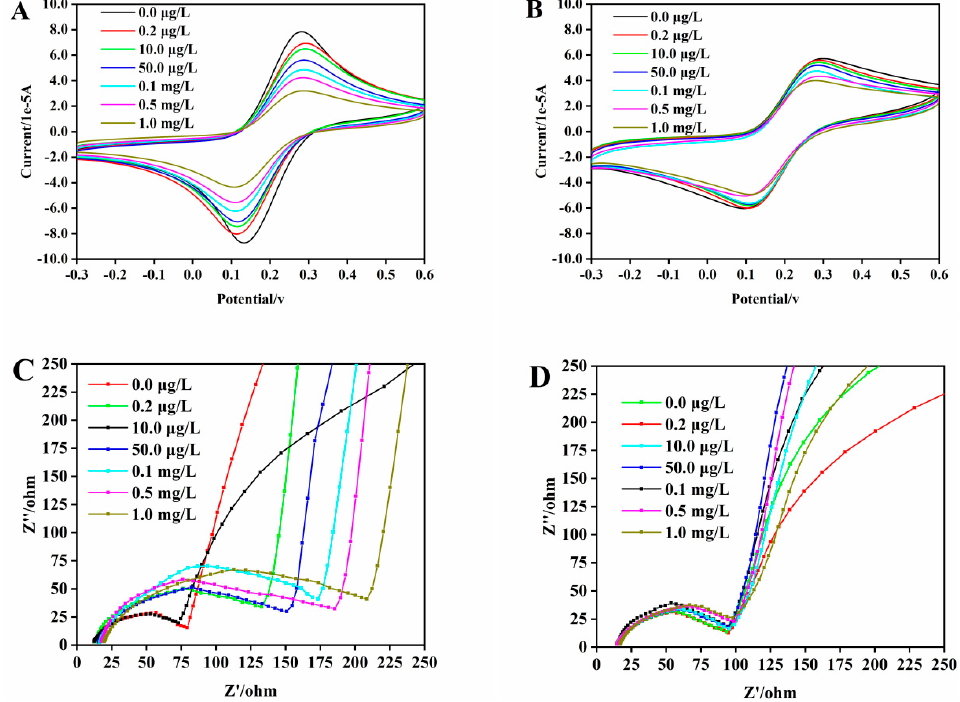
Figure 9. ( A ) CVs of MIP-QDs / GCE; ( B ) NIP-QDs / GCE; ( C ) EIS curves of MIP-QDs / GCE; ( D )NIP-QDs / GCE responses of the proposed MIECL sensor in the presence of various CYF concentrations (0.2 µ g / L, 10.0 µ g / L, 50.0 µ g / L, 0.1 mg / L, 0.5 mg / L, 1.0 mg / L) in 5.0 mmol / L [Fe(CN) 6 ] 3 − / 4 − containing 0.1 mol / L KCL solution.